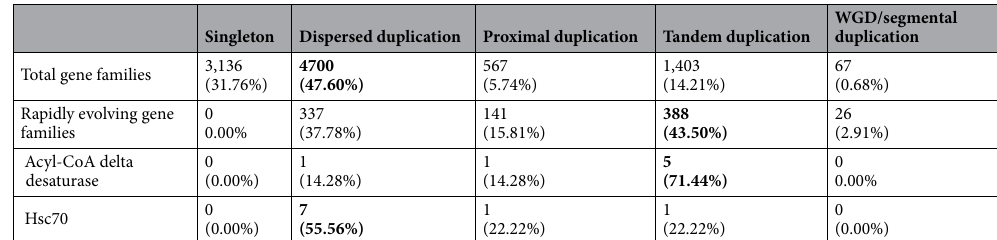
Singleton Dispersed duplication Proximal duplication Tandem duplication